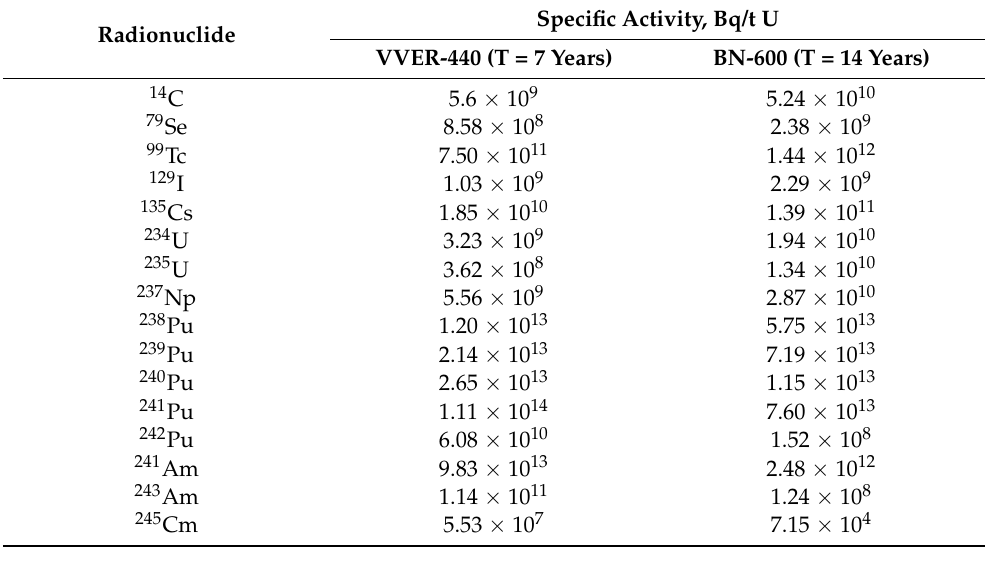
Table 5. Specific activity of significant radionuclides from VVER-440 and BN-600 nuclear reactors SNF [59].